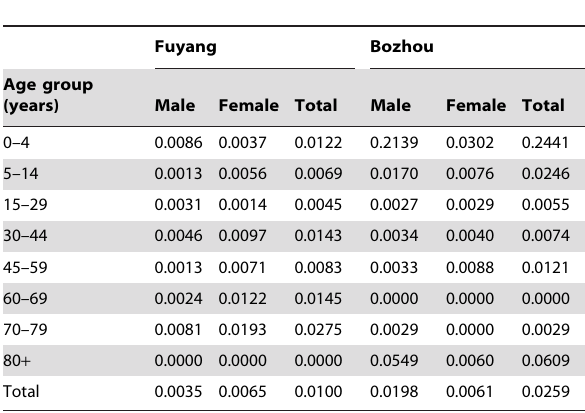
Table 5. YLD per 1000 of infectious diarrhea among age-sex groups in the